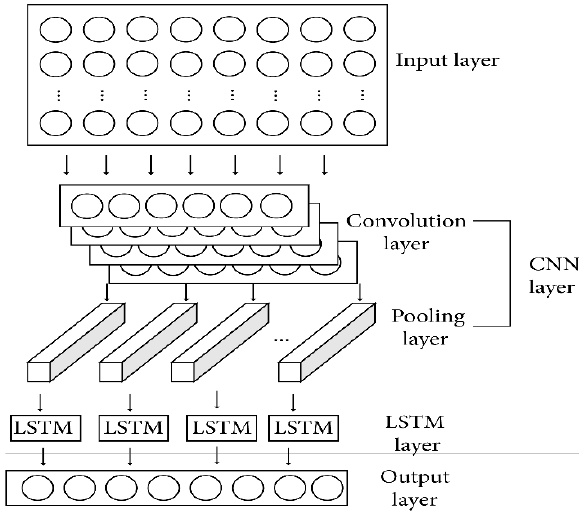
Figure 3. Convolution – Long Short term Memory Hybrid (CNN-LSTM)